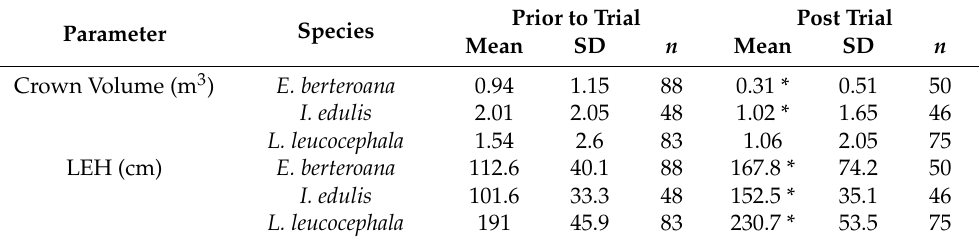
( p < 0.01). Table 2. Mean and standard deviation (SD) of change per individual tree in crown volume (m 3 ) and leaf emergence height (LEH, cm) prior to and post a cattle browsing experiment on individuals ( n ) of potential browse species, E. berteroana , I. edulis and L. leucocephala . Significant differences prior to and post browsing trial ( p < 0.05) are denoted by an asterisk (*).